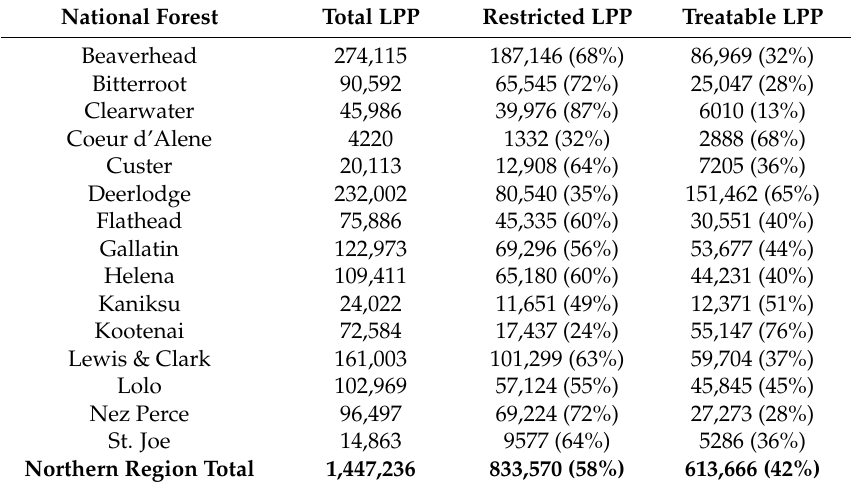
Table A2. LPP forest areas (probability of LPP occurrence greater than 50%) for all National Forests in USDA Forest Service Northern Region (2002): Total LPP area, Restricted LPP area, and Treatable LPP area. Values are hectares (percent of total in parentheses). Restricted area includes lands designated as Wilderness Area or Inventoried Roadless Area; Treatable area is the remainder, and does not account for any additional administrative, physiographic, or economic